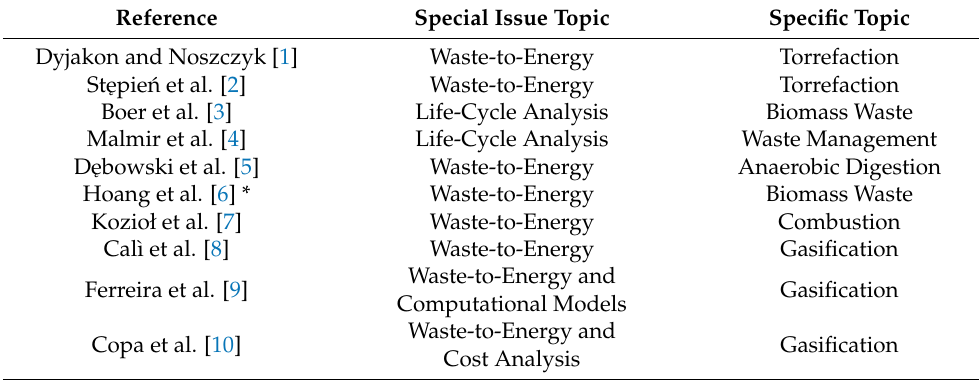
Table 1. Summary of the Special Issue